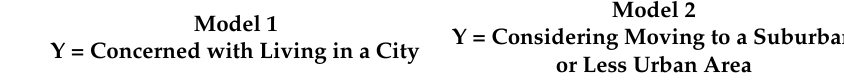
Table 5. Models explaining post-COVID-19 residential